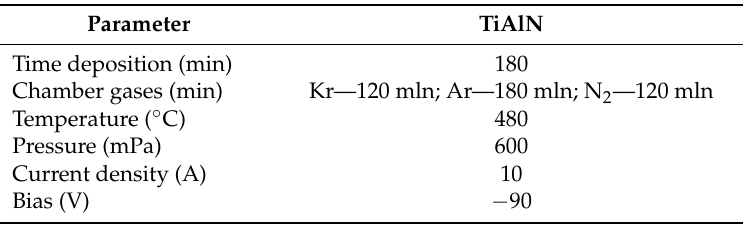
Table 1. Deposition